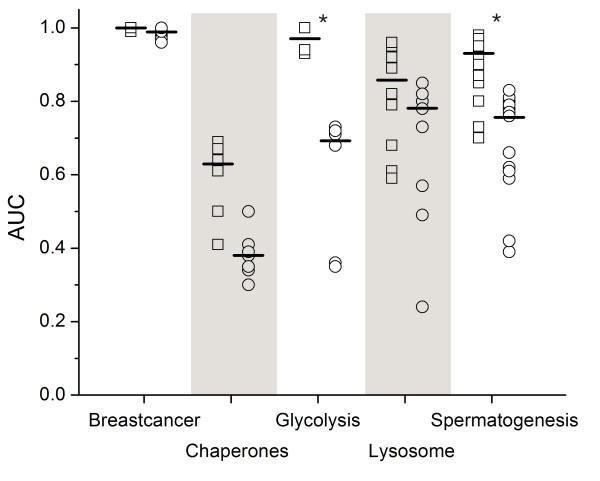
Area under the curve scores for individual genes per group for the concept profile method (open boxes) and the ACS (open circles). An asterisk above a group indicates that the difference in performance of the two methods is statistically significant (at the 0,05 level).